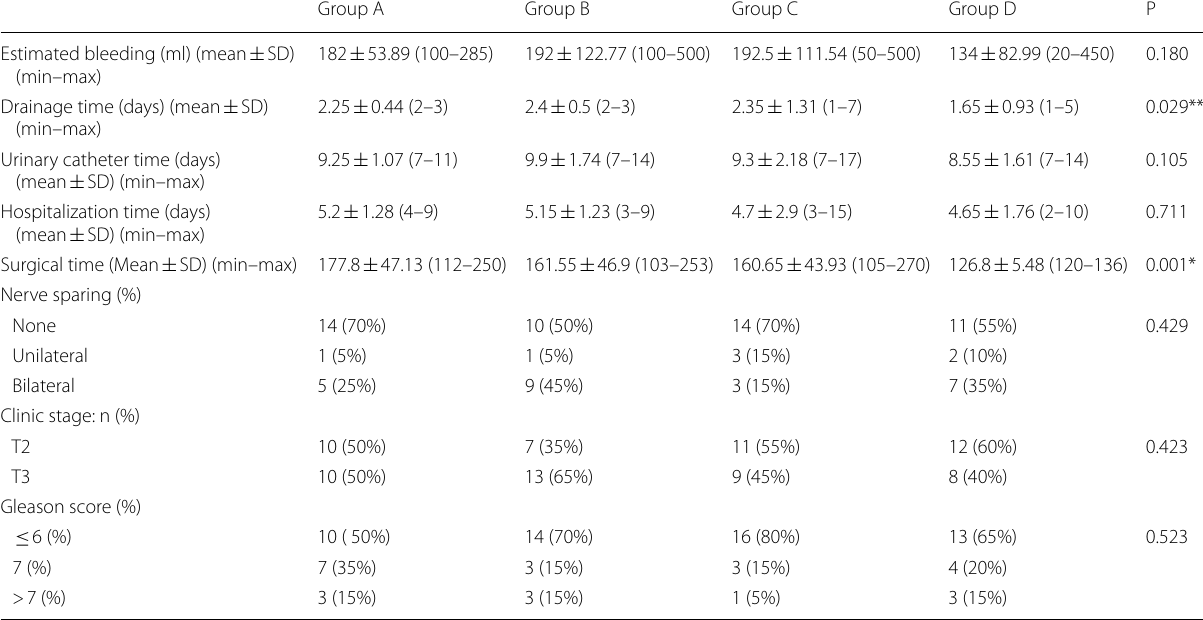
Table 2 Intraoperative and postoperative variables